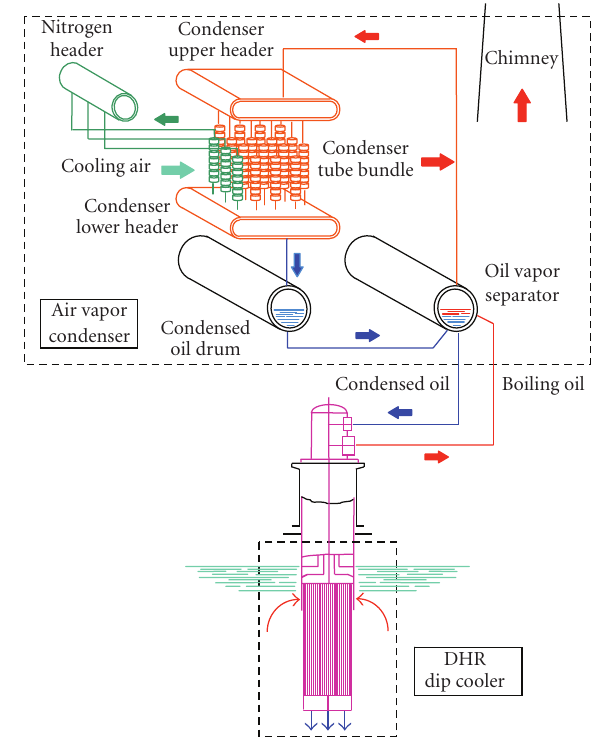
Figure 2: Functional scheme of one DHR loop.